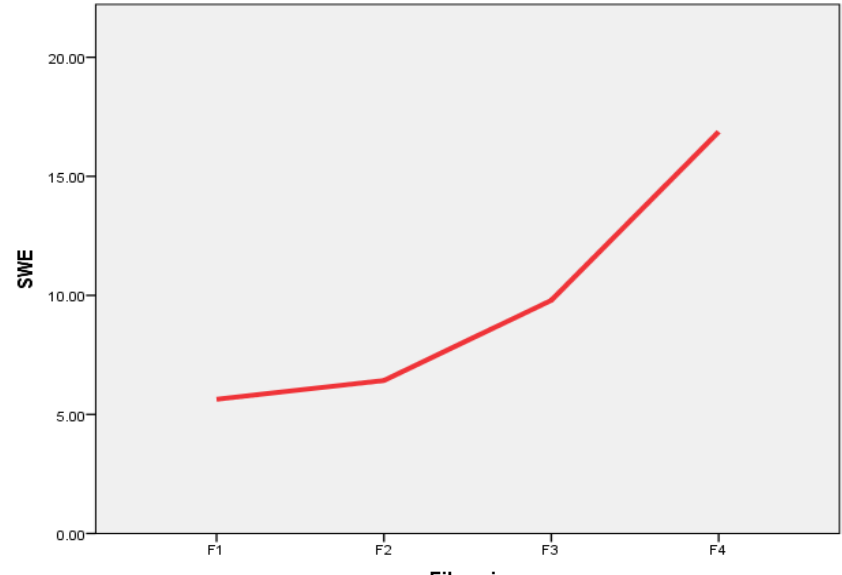
Figure 7. The 2D-SWE correlation with increasing liver fibrosis stage. Direct positive association is seen between liver fibrosis stage according to METAVIR and liver stiffness (2D-SWE), measured in kPa. SWE—2D-SWE value represented in kPa; Fibrosis—liver fibrosis evaluated in liver biopsy specimens according to METAVIR.